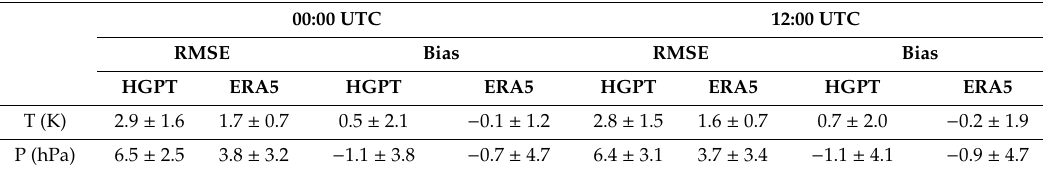
Figure 8. Global distribution of the mean RMSE values: ( a ) mean RMSEs for surface air temperature at 00:00 UTC (K) and ( b ) mean RMSEs for surface pressure at 00:00 UTC (hPa). Table 1. Statistical analysis. RMSE and bias values (with standard deviation) between the HGPT model and radiosondes and the original signal (ERA5 simulations) and radiosondes, for 00:00 and 12:00 UTC. A negative bias indicates overestimation by the HGPT or ERA5 models and a negative bias indicates an underestimation.